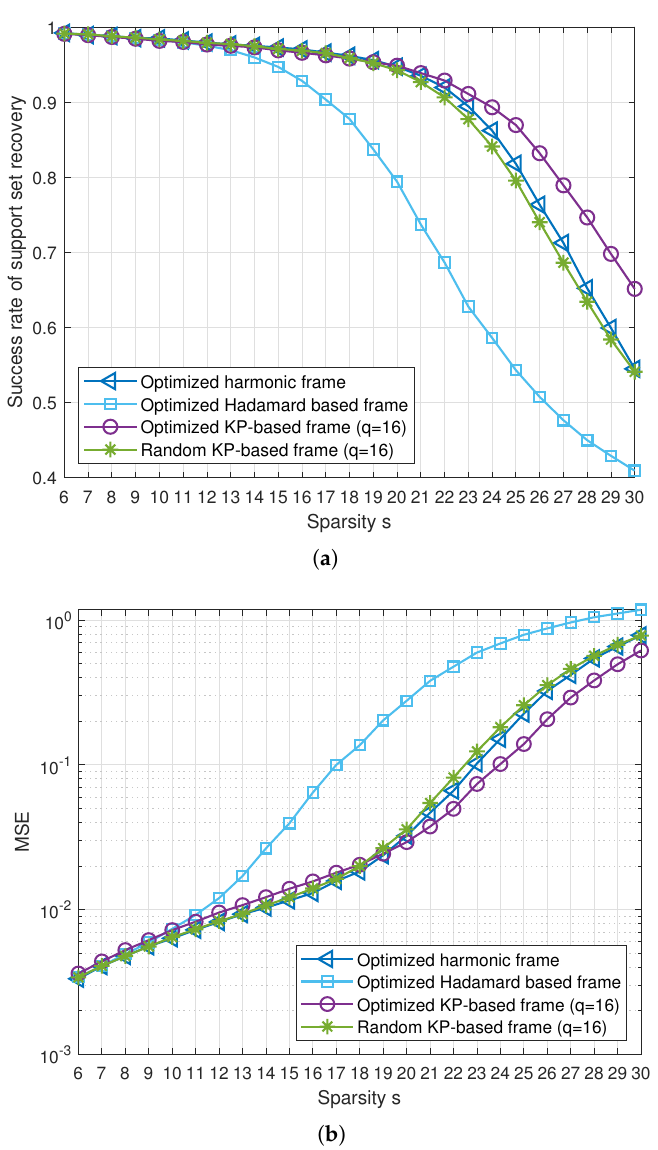
Figure 4. Performance of sparse signal recovery for various frames of N = 256 and m = 64. ( a ) Success rate of support set recovery, ( b ) mean squared error